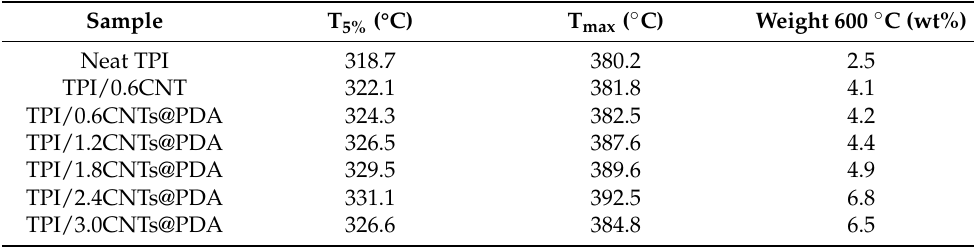
Figure 9. TGA ( a ) and DTG ( b ) analysis of TPI composites. Table 3. TGA parameters of TPI composites. Table 3. TGA parameters of TPI